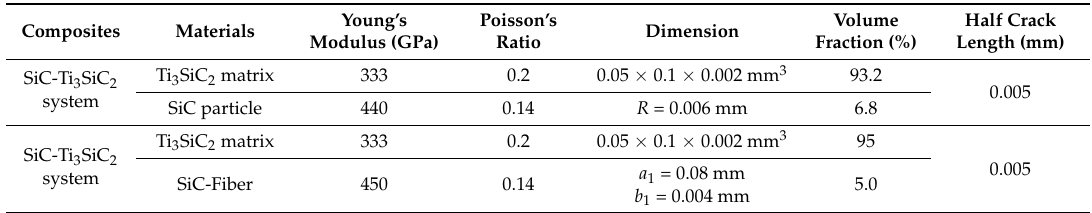
Table 1. Main material parameters in 3D-FEM.